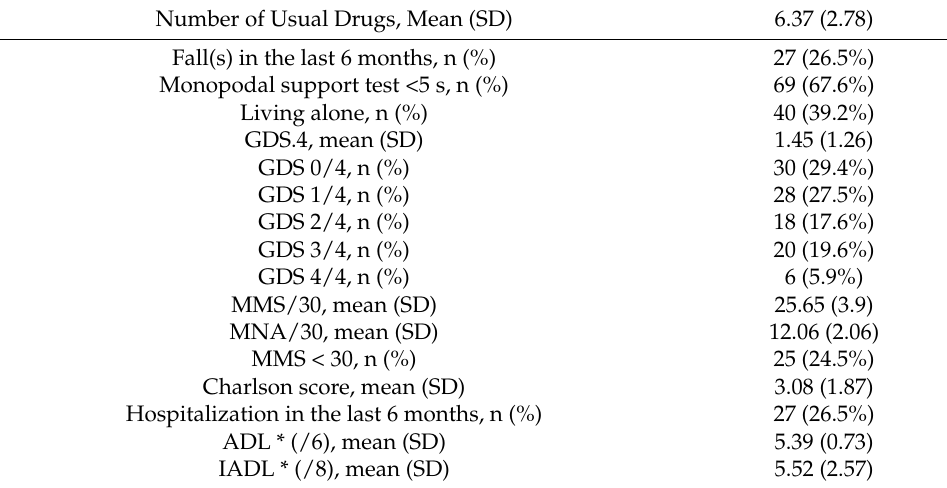
Table 2. Characteristics of the study population (n =